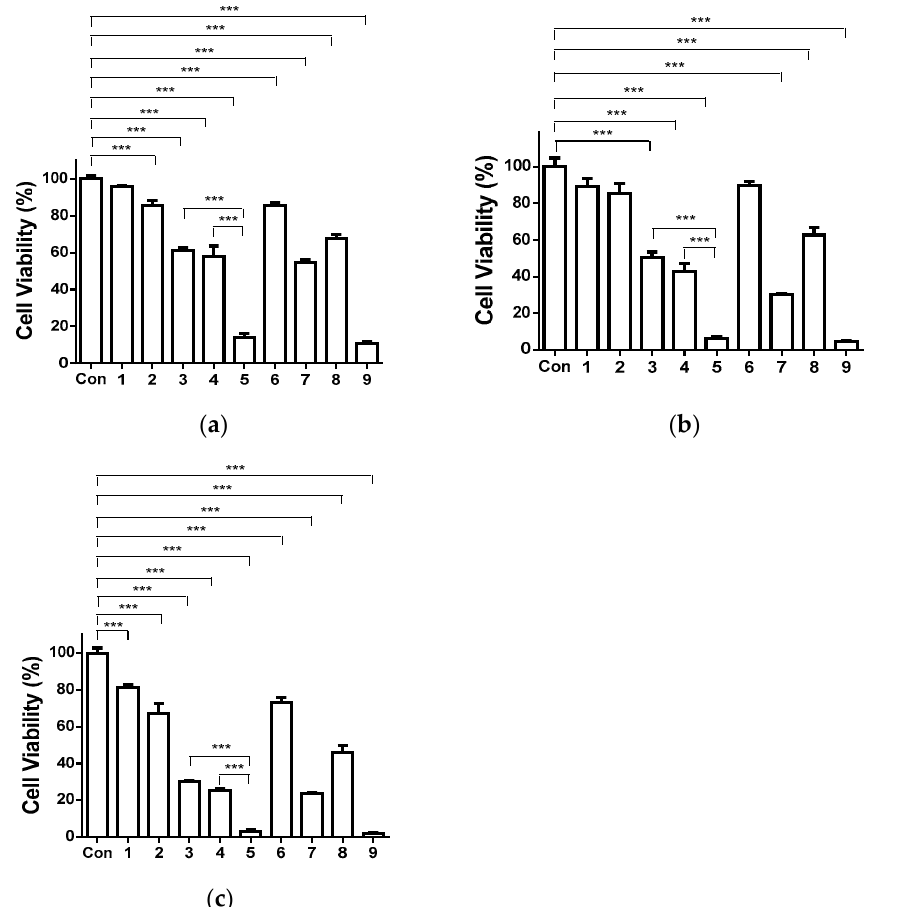
Figure 9. Effect of the different formulations (fibrous mats or solutions) on HeLa tumor cells after 24 ( a ), 48 ( b ) and 72 h ( c ) of incubation. Con—control, HeLa cells; 1—crPVA mat; 2—cr(PVA/Ch) mat; 3—cr(PVA/Ch)/SQ mat; 4—Fe 3+ complex of cr(PVA/Ch)/SQ mat; 5—Cu 2+ complex of cr(PVA/Ch)/SQ mat; 6—free Ch; 7—free SQ; 8—SQ.Fe 3+ and 9—SQ.Cu 2+ . All SQ-containing formulations and their complexes were tested at a concentration of SQ 340 µg/mL of culture medium. *** p < 0.001.